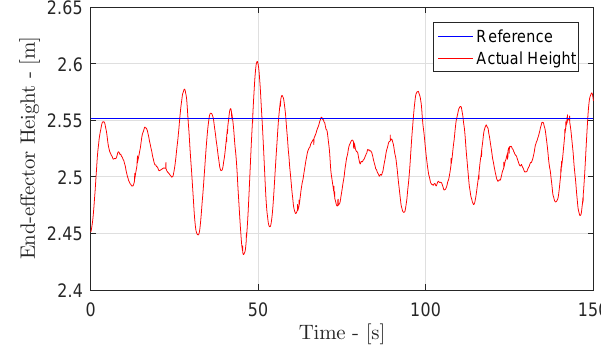
Figure 24: Experimental location 1.